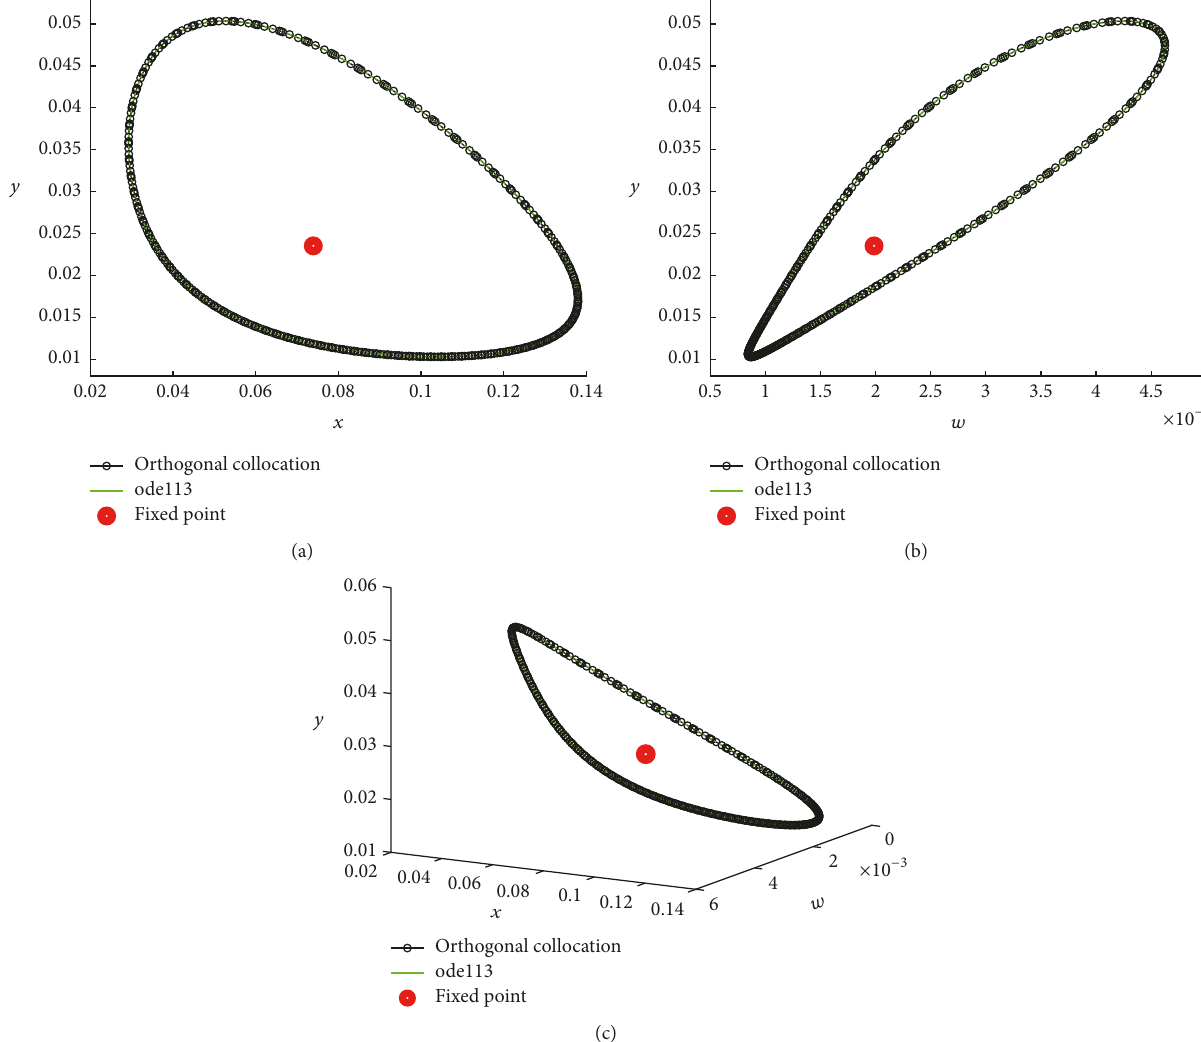
Figure 5: Stable cycle generated by supercritical Hopf bifurcation in 𝑥𝑦 (𝑆𝐼) , 𝑤𝑦 (𝐸𝐼) planes and in 3 D (𝑆𝐸𝐼) , respectively, for (𝑟,𝛼,𝜀,𝑚,𝑠,𝛾,𝜎,𝛽) = (10 −4 , 10 −4 ,10 −3 , 0.5, 1.2, 0.042, 0.5, 0.328525) ( 𝛽 = 0.338525 ), determined by a custom orthogonal collocation on cr finiteelements algorithm. Unstableendemic equilibrium(redmarker): (𝑥 0 , 𝑤 0 ,𝑦 0 ) = (0.073948, 0.001986, 0.023535) .Period: 𝑇 = 410.572533 days. ode113: Adams-Bashforth-Moulton PECE solver of orders 1 to 12